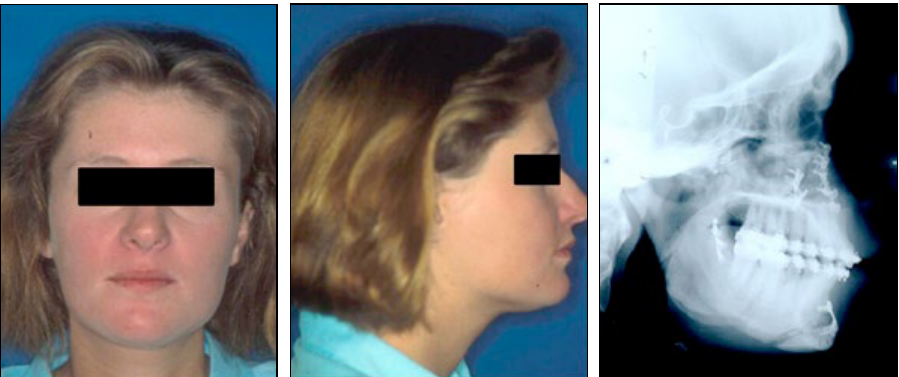
Figure 3. Post-surgical photographs and cephalogram of a patient treated by clockwise rotation of the occlusal